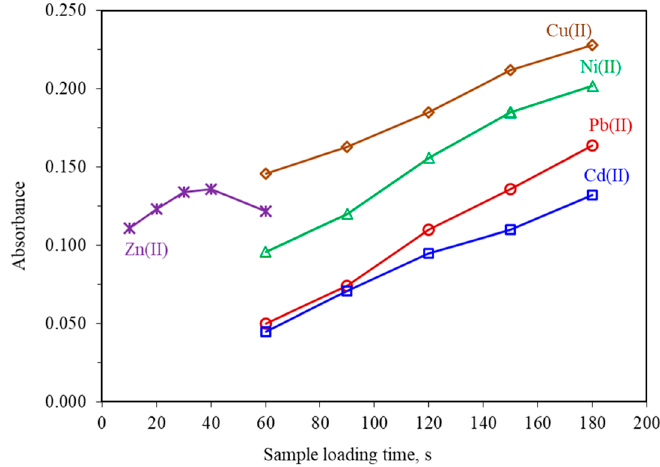
Figure 4. Effect of loading time on the absorbance of 10.0 μ g L − 1 Cu(II), 20.0 μ g L − 1 Ni(II), 5.0 μ g L − 1 Zn(II), 50.0 μ g L − 1 Pb(II) and 10.0 μ g L − 1 Cd(II). All other parameters as given in Table 1.